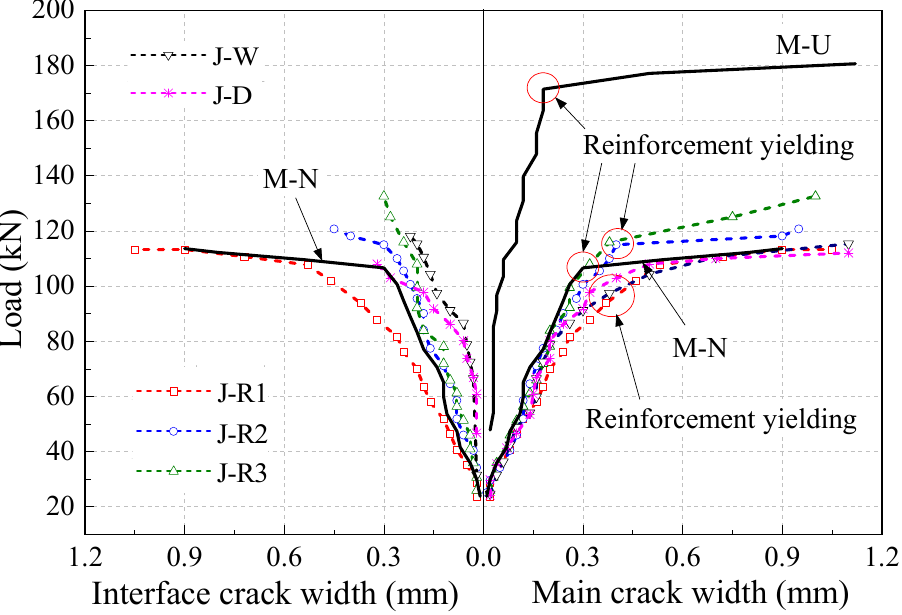
Figure 5. Load versus width of main crack and cracks at interface. The curves on the left side of Figure 5, show the comparisons of the crack opening rates at their interfaces of test specimens. Among them, the curve for J-R1 is just mirror images of that on the right side, since the crack initiated at the interface of J-R1 has developed into the main crack. The width of this interfacial crack grew apparently faster than the monolithic specimen M-N, which meant the interface bonding could not